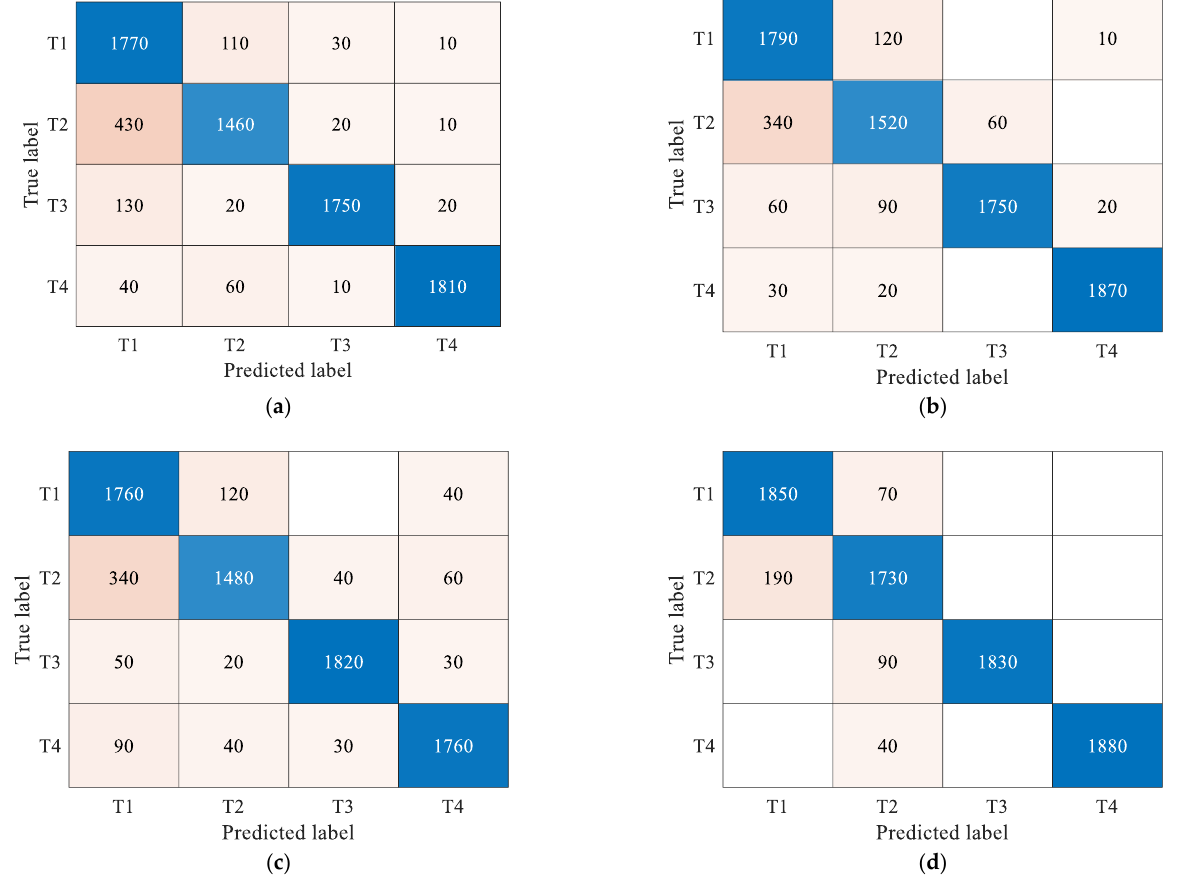
Figure 8. ( a ) MTF-8; ( b ) GASF; ( c ) GADF; ( d ) RP (4, 5). Confusion matrices of different encoding